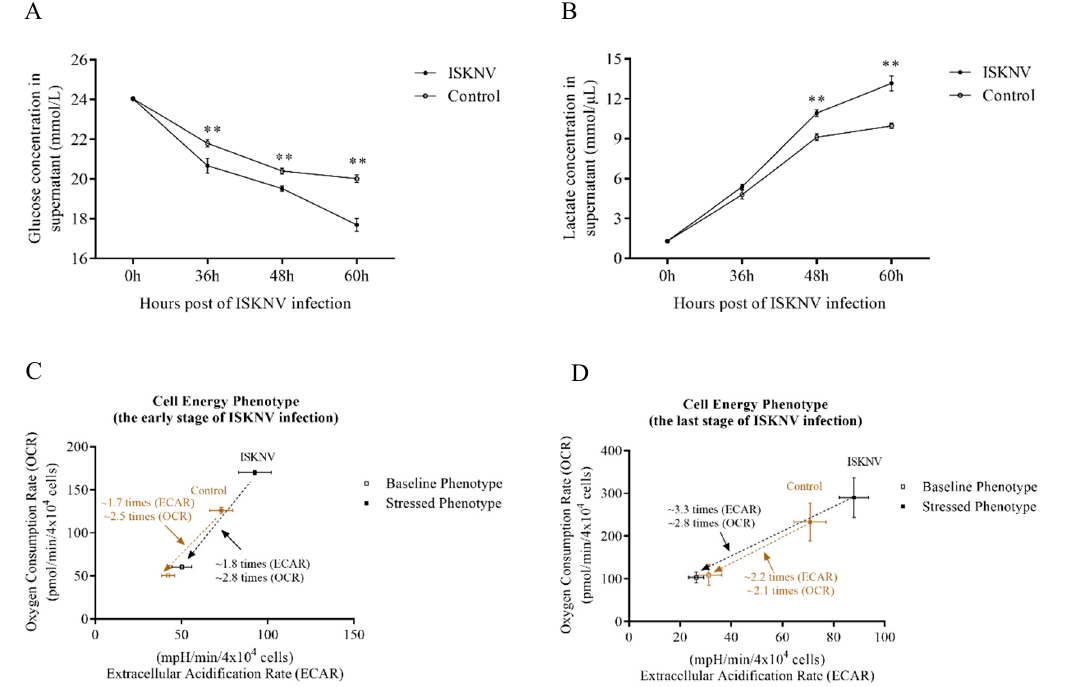
Figure 3. The ISKNV infection induced the Warburg e ff ect at the late stage, but not at the early stage. ( A ) and ( B ) represent the change of concentration of glucose and lactate in supernatant, respectively. ( C ) Seahorse Bioscience extracellular flux analyzer was used to measure the cell energy phenotype (early stage of ISKNV infection) in control- and ISKNV-infected CPB cells. ( D ) Seahorse Bioscience extracellular flux analyzer was used to measure the cell energy phenotype (late stage of ISKNV infection) in control- and ISKNV-infected CPB cells. Data are normalized to cells number. * p < 0.05; ** p < 0.01.